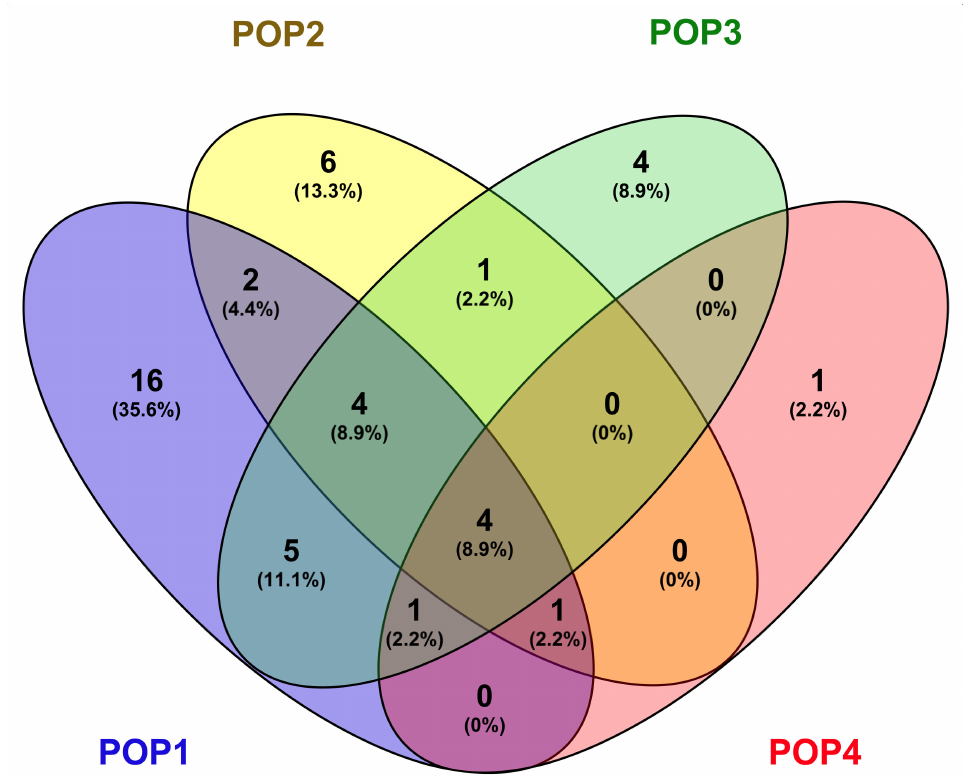
Figure 5. Distribution of sources of origin of germplasm lines among the four